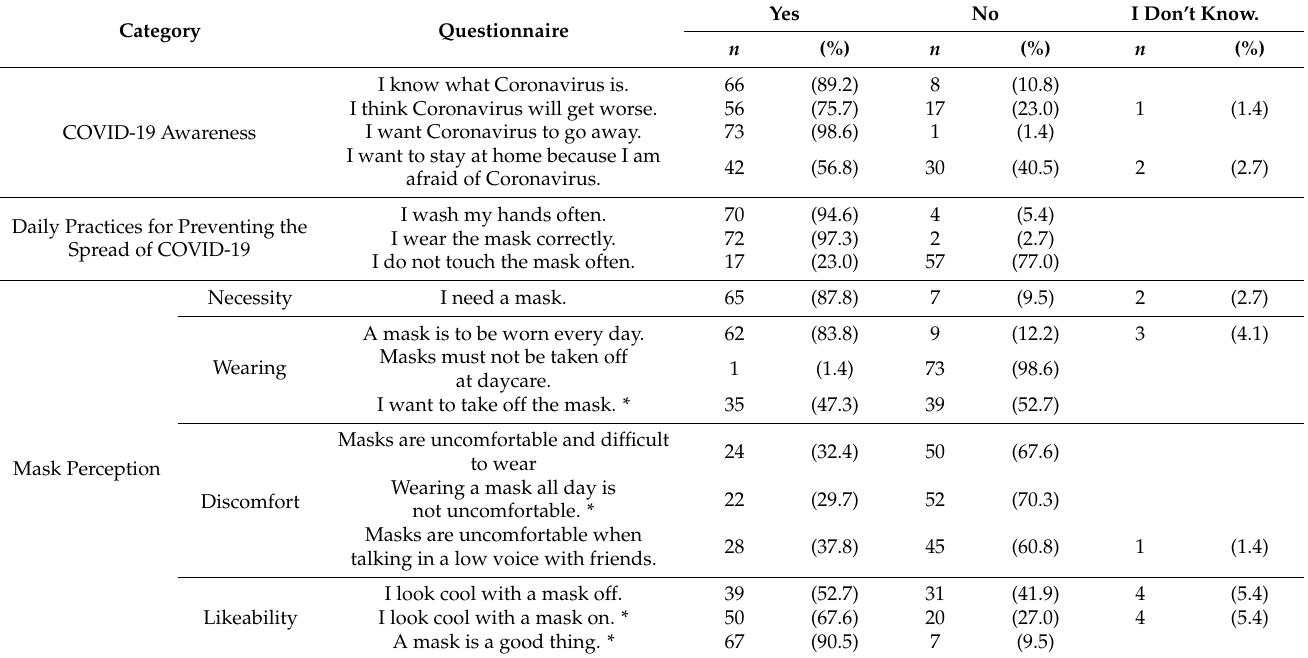
Table 3. Questionnaire and the children’s responses (*: a significant age